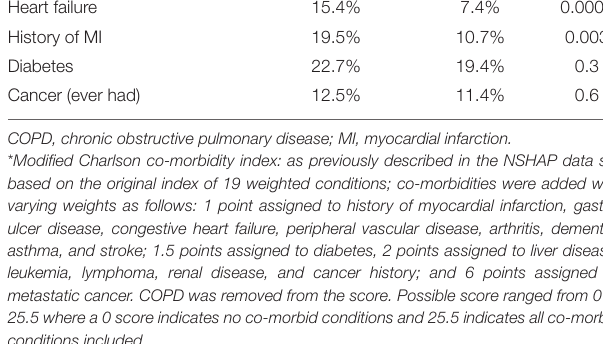
Older adults with self-reported COPD had significantly